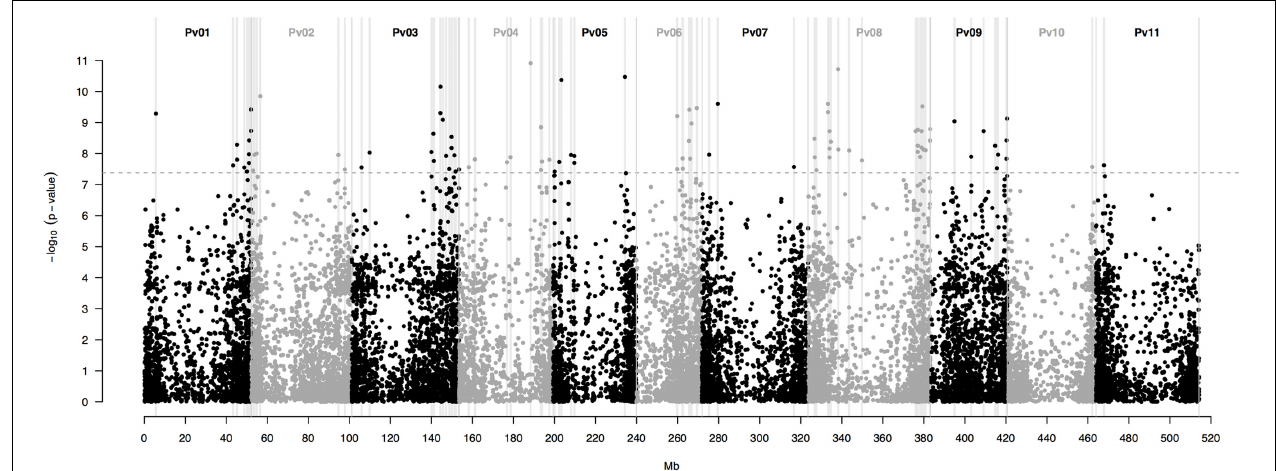
FIGURE 3 | Manhattan plot of the optimum genome-environment association (GEA) analysis for drought tolerance in 86 common bean accessions based on 22,845 GBS-derived SNP markers. The bioclimatic-based drought index follows Cortés et al. (2013). The Manhattan plot despites per-marker –log 10 ( P -value) according to a mixed linear model with a centered IBS kinship matrix as a random effect, and the first two PCoA axes scores (Figure 2) as covariates. The gray dashed horizontal line marks the P -value threshold after Bonferroni-correction for multiple comparisons. Black and gray colors highlight different common bean (Pv) chromosomes. Gray vertical boxes indicate the 1,000 bp flanking region of each marker that was associated with the bioclimatic-based drought index.